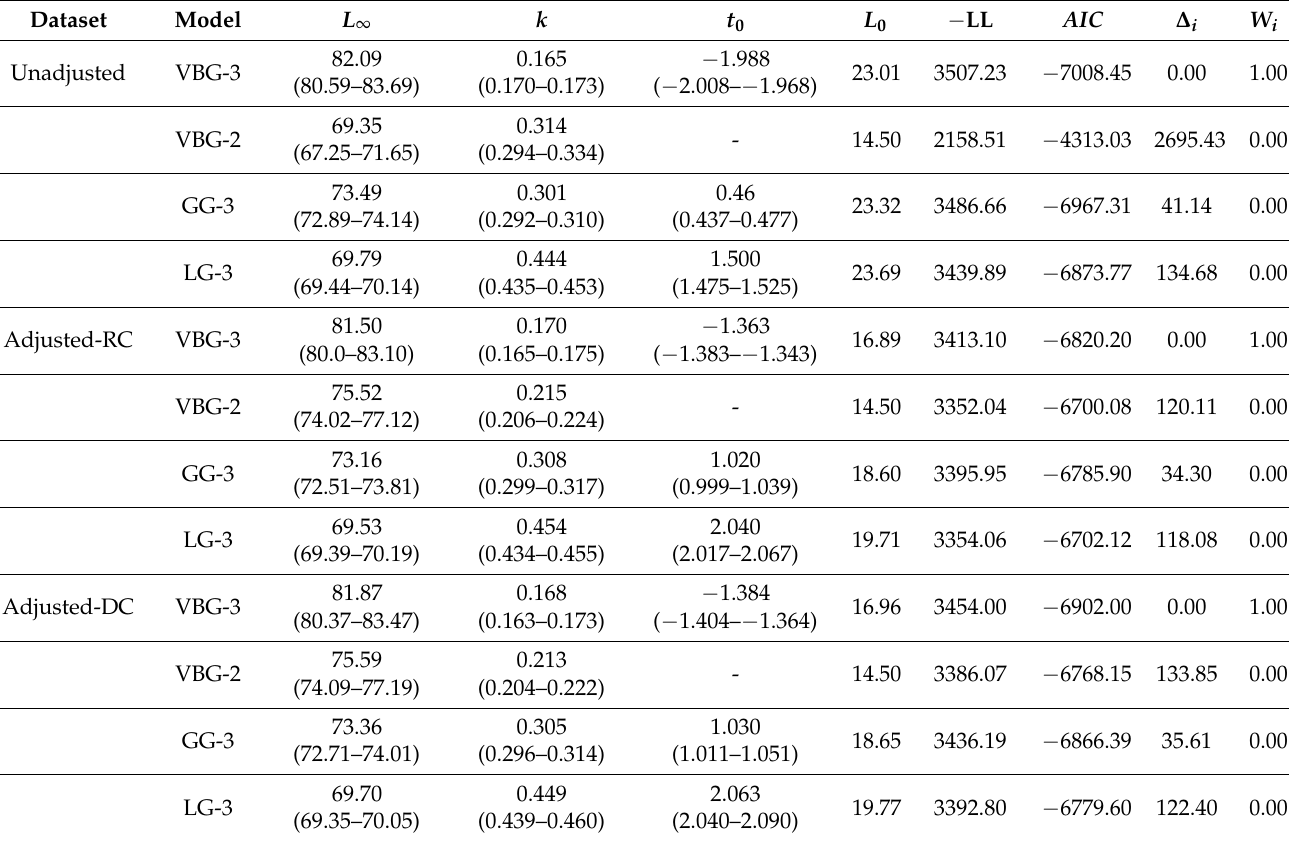
Table 4. Growth model parameter estimates of female N. entemedor using three different data sets (unadjusted, adjusted to reproductive cycle (RC) and adjusted to the reproductive cycle and date of capture (DC); see text for details). L ∞ is the theoretical asymptotic size, k is the growth coefficient, L 0 is the birth size estimated at age 0, t 0 is the hypothetical age at length zero, − LL is negative log-likelihood, AIC is Akaike’s Information Criterion, ∆ i is the Akaike difference, and W i is the AIC weight estimates. CIs estimated from log-likelihood contours are shown in